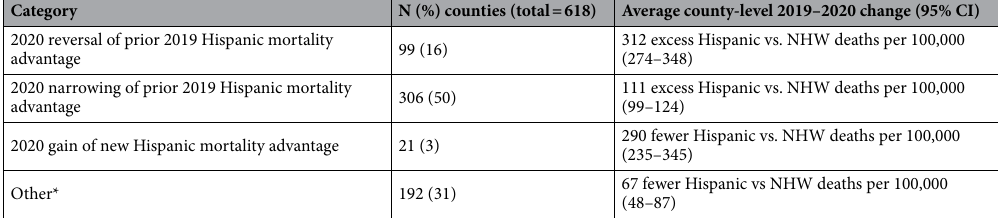
Table 2. US county-level changes in Hispanic versus Non-Hispanic White age-adjusted mortality categorized according to effect on the Hispanic mortality advantage, 2019–2020. Abbreviations: NHW Non-Hispanic White. *Other—includes those with a 2019 Hispanic mortality advantage which further increased in 2020 and those with no Hispanic mortality advantage in both 2019 and 2020.